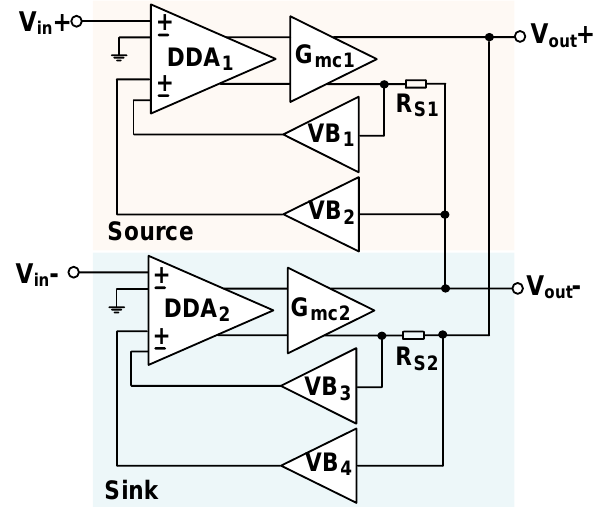
Figure 3. Schematic of the balanced current driver.